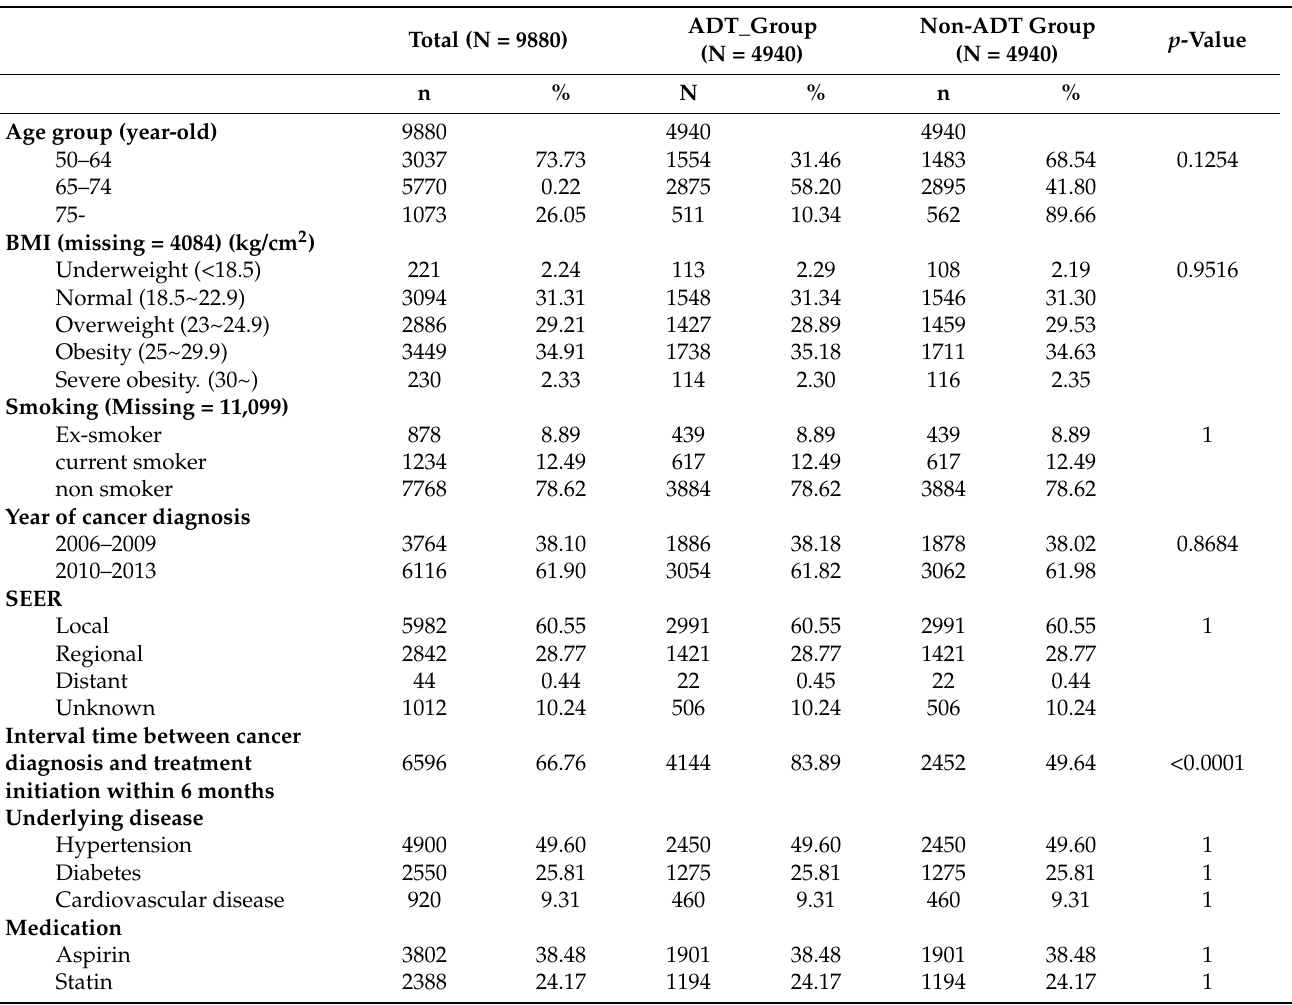
Table 1. Comparison of demographics between ADT and non-ADT groups among patients with prostate cancer after 1:1 propensity score matching adjusted variables for age, BMI, smoking, diag- nosed year of cancer and dementia, SEER stage, underlying diseases, medications, and Charlson comorbidity